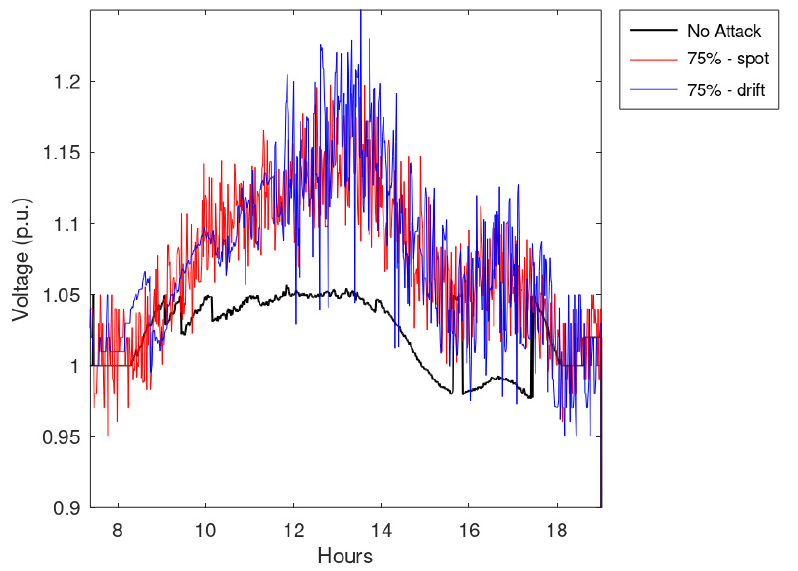
Figure 14. Maximum network voltage during the timestamps considering 75% of the measurements falsified.